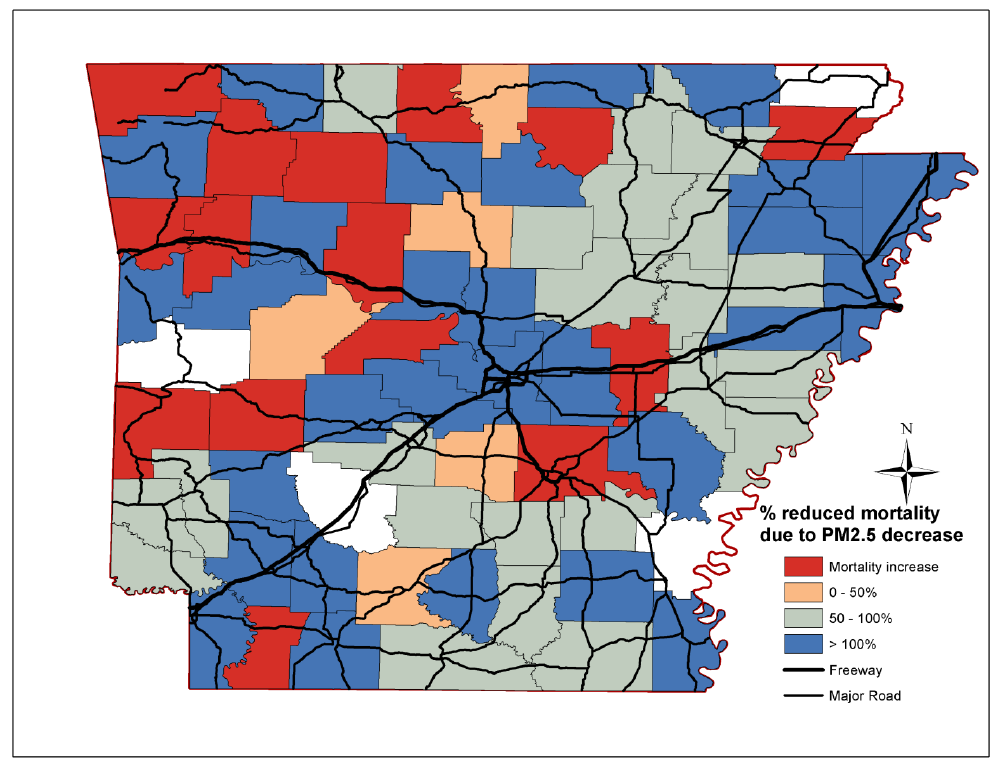
Figure 5. Percentage reduction of stroke mortality attributed to PM Arkansas county.